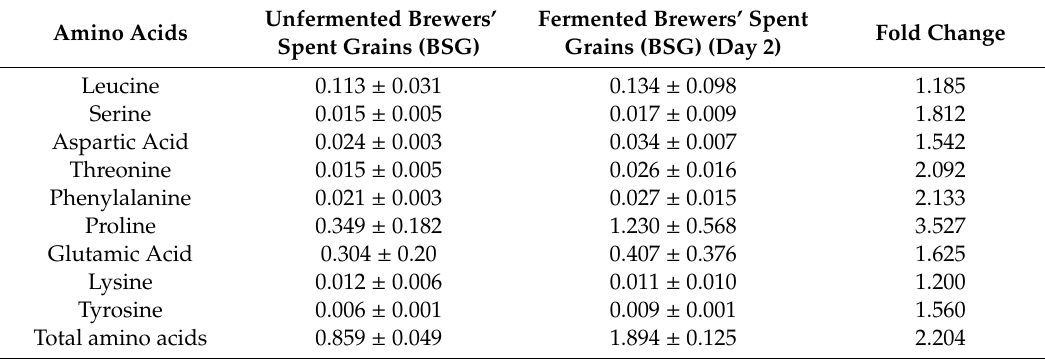
Table 1. Amino acids results (mg / g) before and after fermentation.